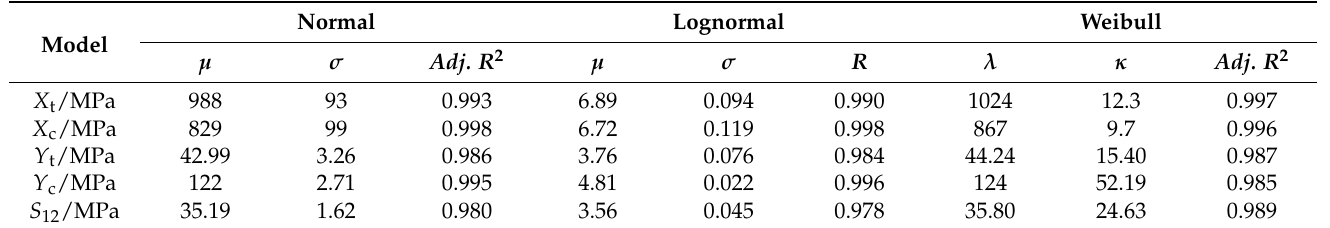
Table 10. Values of the three statistical distribution parameters for the strength properties of H-GFRPs under the ETW condition.